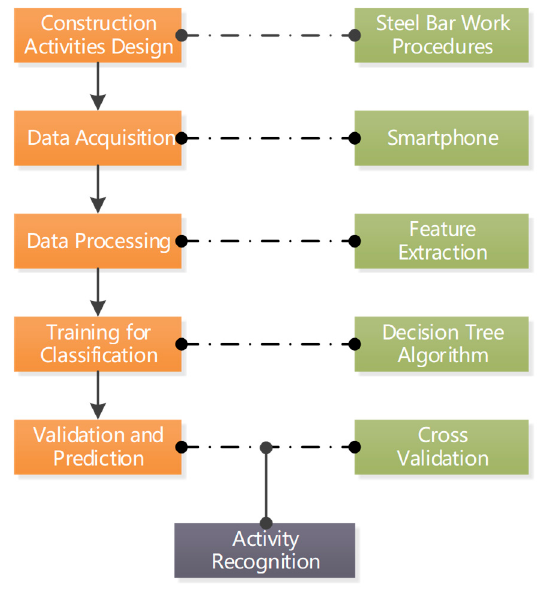
Figure 1. The framework of construction workers’ activity.